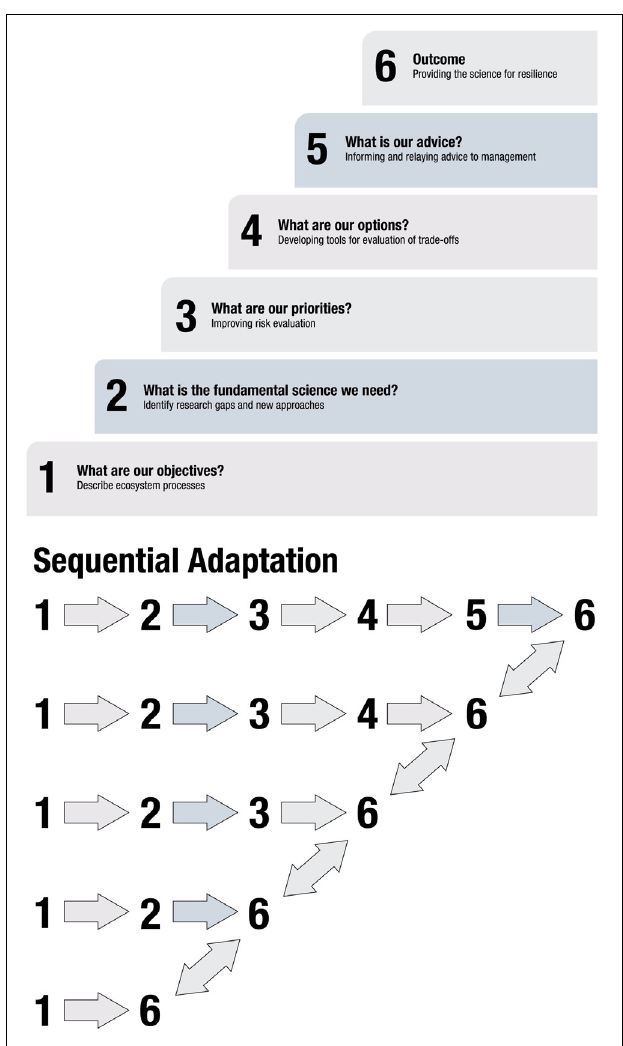
FIGURE 1 | (A) Modified from NOAA Fisheries (2016a) are the six tiers that should be achieved to implement ecosystem-based fishery management. We have modified the tasks within each tier to describe how a research program can provide the appropriate information for inclusion in an EBM strategy. (B) A demonstration of the sequential re-evaluation and adaptation of the process. As the results accumulate from each tier of complexity an advisory body should undertake an evaluation of the process and results and if there is a disconnect between objectives, science, models and policy advice, the practitioners should fall back a level ideally until consensus among advisory members is met regarding next